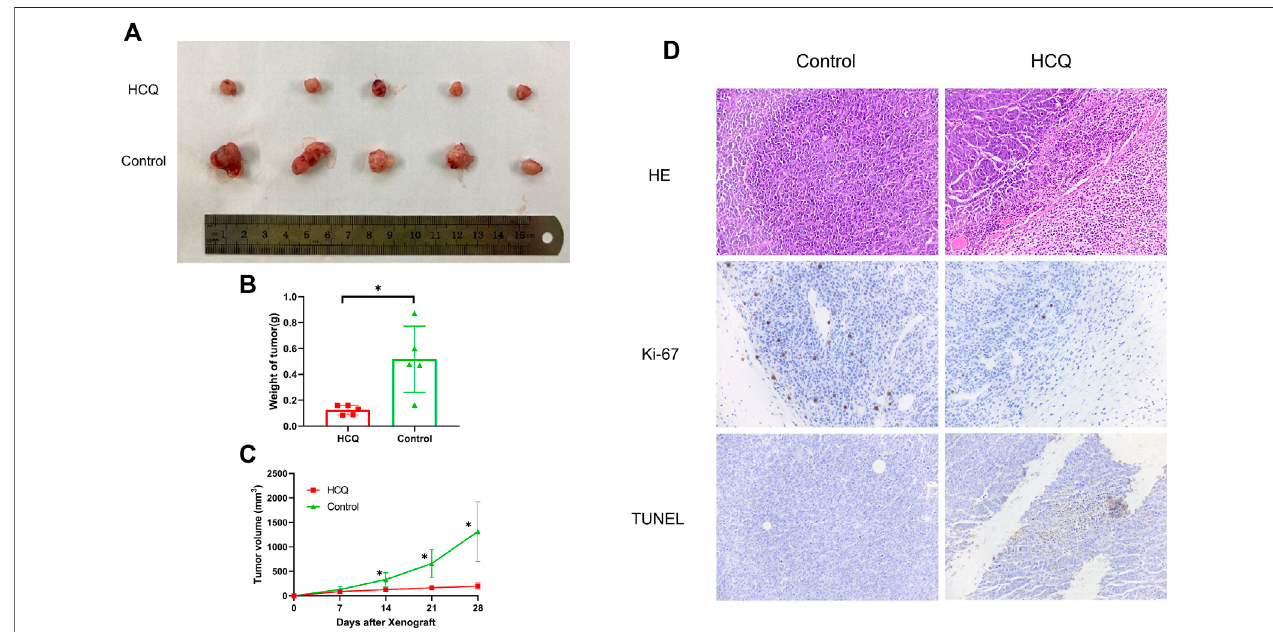
FIGURE7| HCQsuppressesthetumorgrowthinthecholangiocarcinomaxenograftmodel. (A) AntitumoractivityofHCQ(100 mg/kg)innudemice,representative xenografts from miceafter subcutaneous injection of CCLP-1 cells and treatment ofHCQ. (B) Tumor weights of each group measured at the end of the treatment. Data are shown as mean ± SD; * p < 0.05 means signi fi cant difference compared with the control group. (C) Tumor volumes of each group measured in indicated days of treatment. All values are expressed as mean ± SD; * p < 0.05 means signi fi cant difference compared with the control group at the same time point. (D) HE, Ki-67, and TUNEL immunohistochemistry assays of tumor tissue. For the IHC results of Ki-67 and TUNEL, yellow stains mean proliferative cells and apoptotic cells,